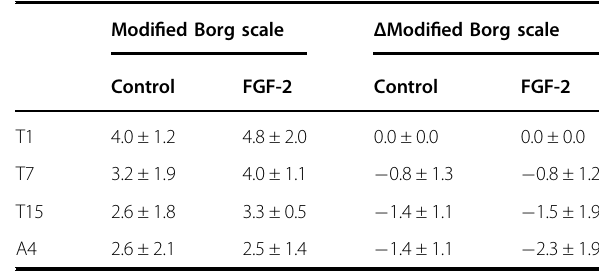
Table 3 ATS scale and Δ ATS scale of each group during and after FGF-2 treatment in a clinical trial ATS scale Δ ATS scale Control FGF-2 Control